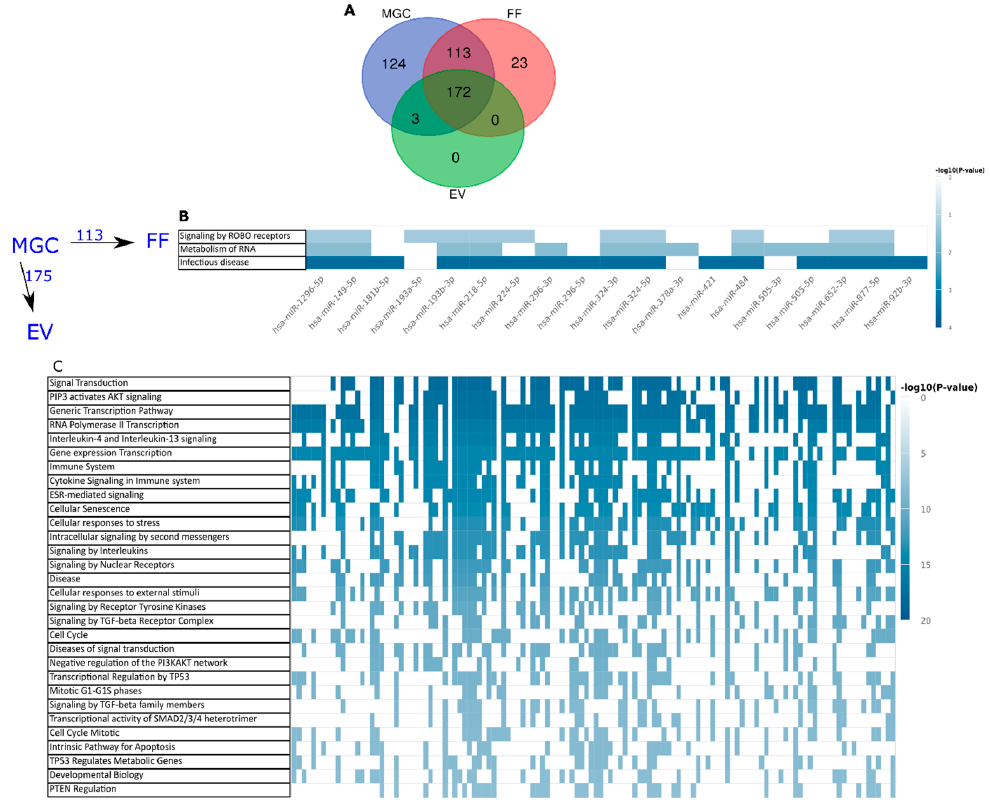
Figure 4. Cellular and extracellular miRNAs observed in ovarian follicles of fertile women. ( A ) Distribution of observed miRNAs (>5 reads in >50% of samples) between sample types. ( B ) Pathways over-represented by the targets of 113 miRNAs secreted by mural granulosa cells (MGC) into follicular fluid (FF) outside of extracellular vesicles (EV). ( C ) Top 30 pathways potentially regulated by 175 miRNAs secreted into FF in EVs. Each column in ( B , C ) corresponds to one miRNA regulating a pathway, if marked in blue.